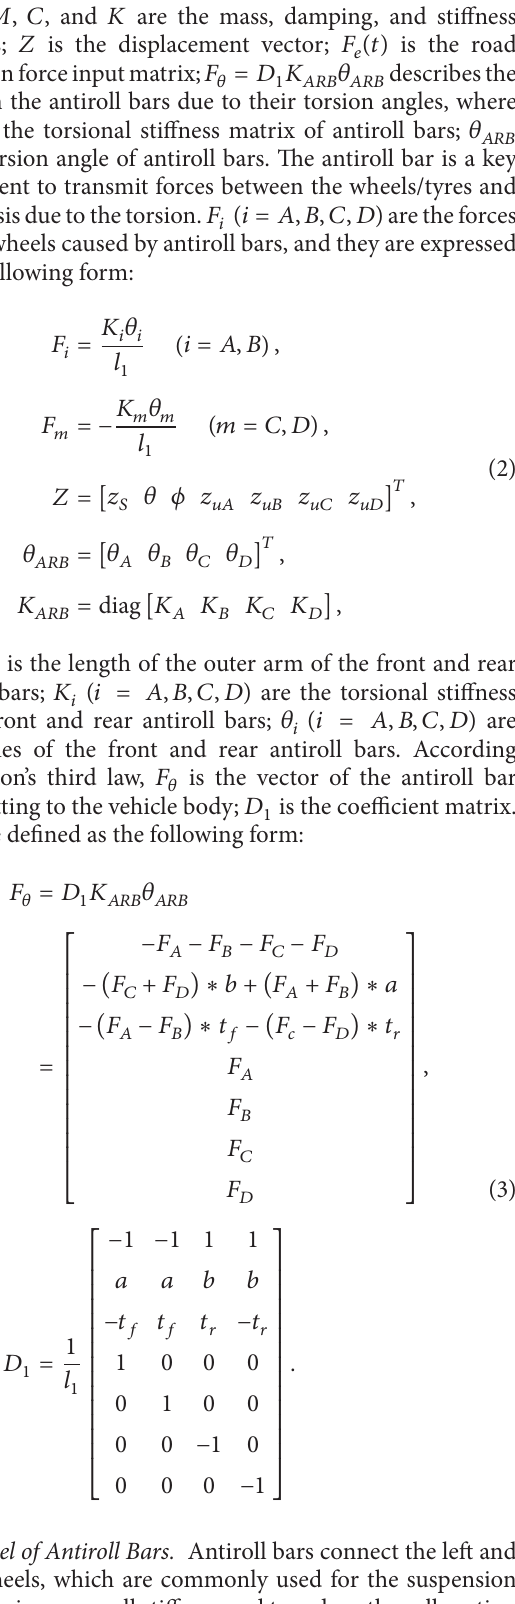
right wheels, which are commonly used for the